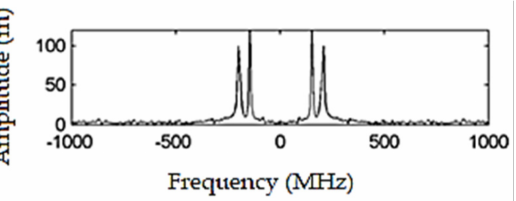
Figure 3. Results for the application of FFT on the output of first element in the array